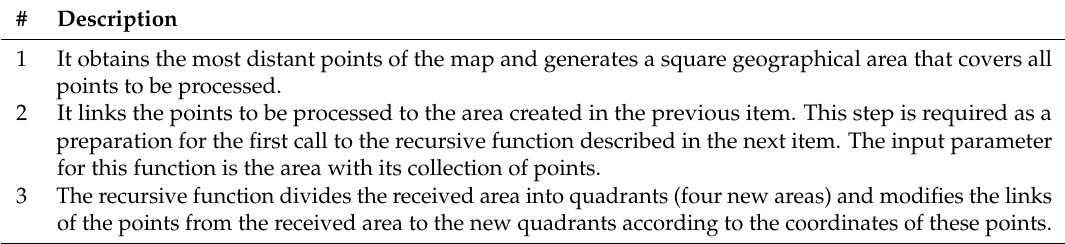
Table 4. Detailed steps of Algorithm 1.1: division into